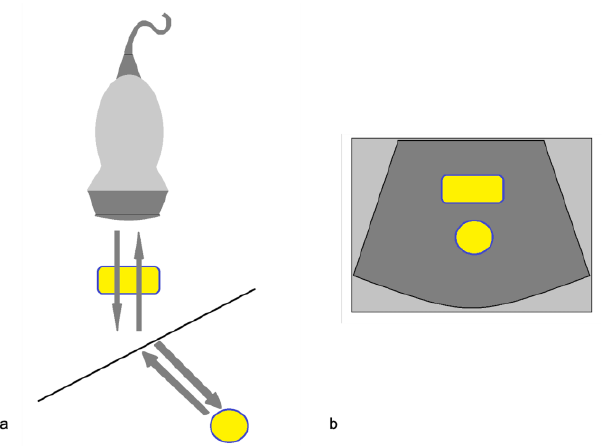
Figure 8. Refraction artifact. ( a ) Diagram shows the refraction or change in direction of the US beam due to an interface at a non-perpendicular angle. The difference in propagation speed between the two tissues can cause refraction to occur. ( b ) The object in the path of the refracted portion of the beam is misplaced because the processor assumes a straight path of the beam. Modified from Feldman MK et al. [5].